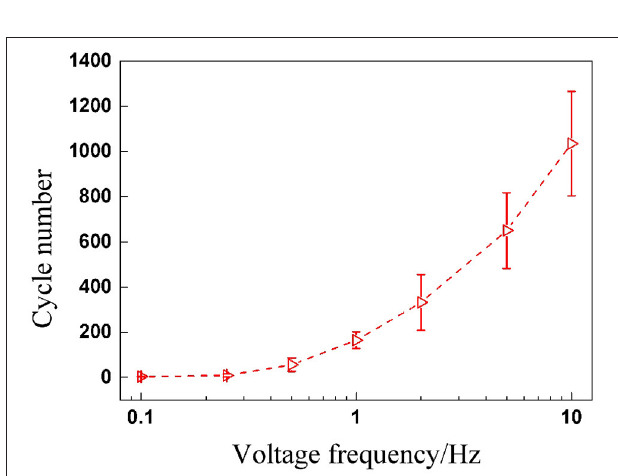
FIGURE 4 | Maximum cycle numbers before breakdown under sinusoidal voltage with different